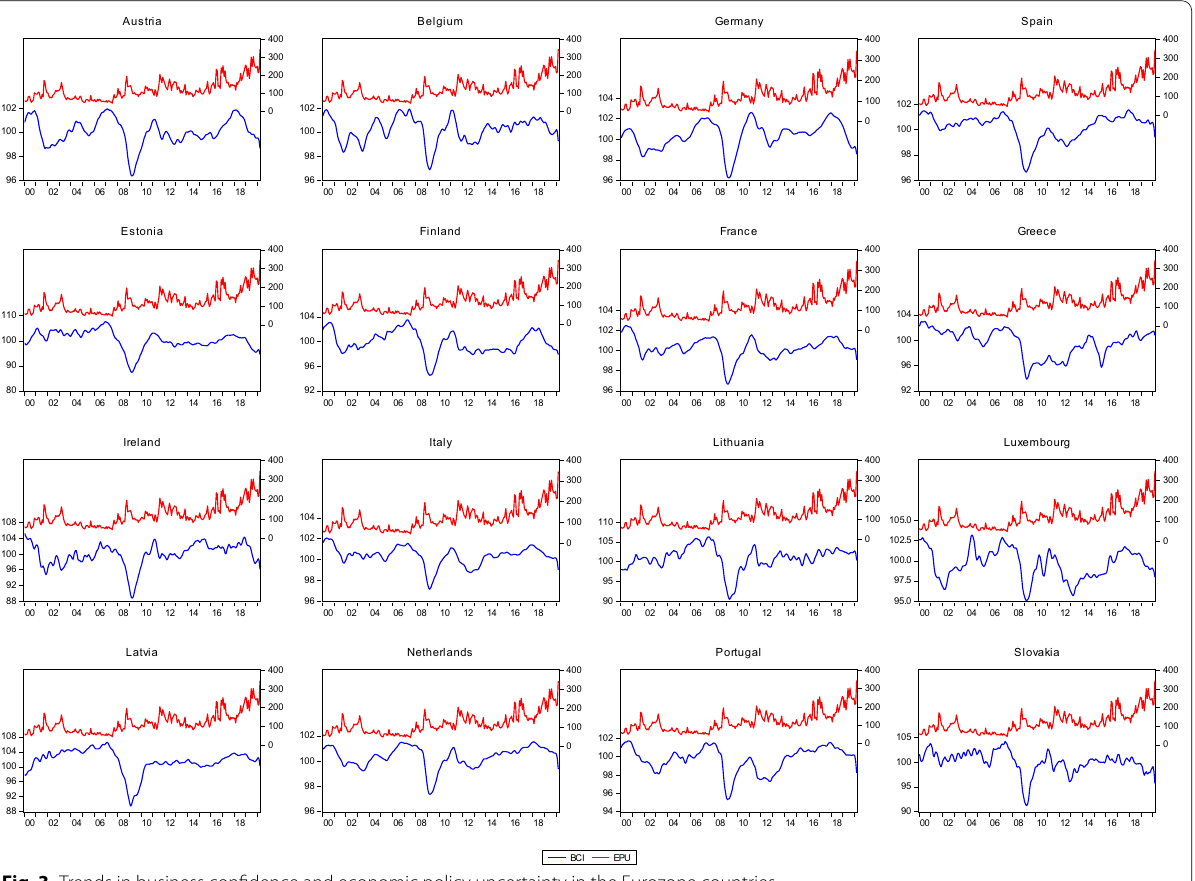
Fig. 3 Trends in business confidence and economic policy uncertainty in the Eurozone